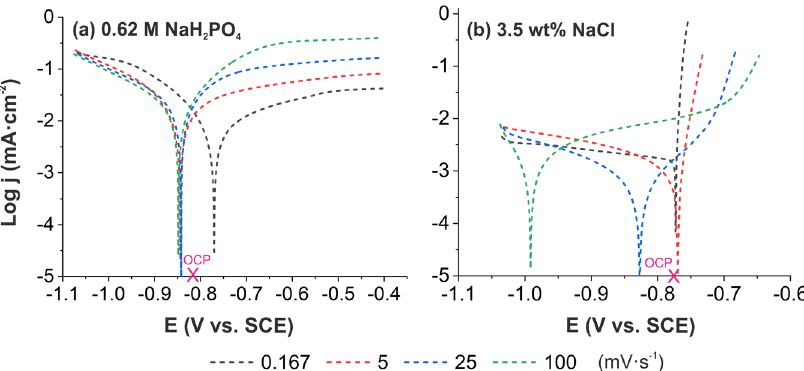
Fig. 1 Experimental PDP of AA7075 at scan rates of 0.167, 5, 25, 100 mV·s − 1 . PDP measured in ( a ) 0.62 M NaH 2 PO 4 and ( b ) 3.5 wt% NaCl solution. The data with a 95% con fi dence interval is presented in the SI (Supplementary Fig.